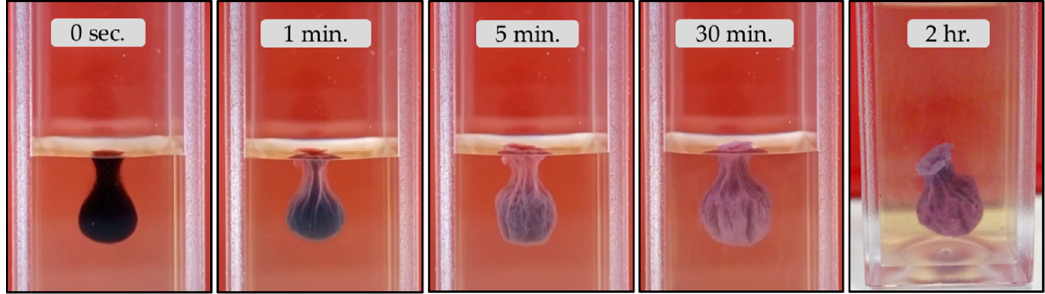
Figure 12. The growth process of cobalt chloride mineral vesicles in Magadi water.